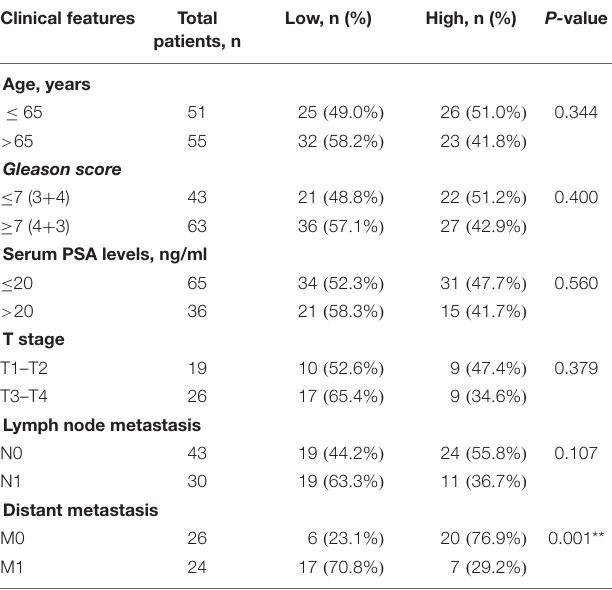
TABLE 1 | Correlation of GADD45B expression with clinico-pathologic characteristics of PCa patients in Sun Yat-sen University Cancer Center (106 patients).